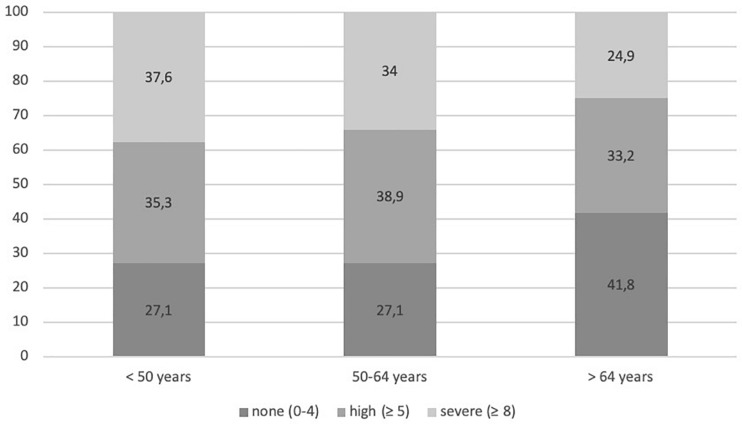
Frequency (%) of distress level measured with the Distress Thermometer in the age groups (<50, 50–64, and >64 years).